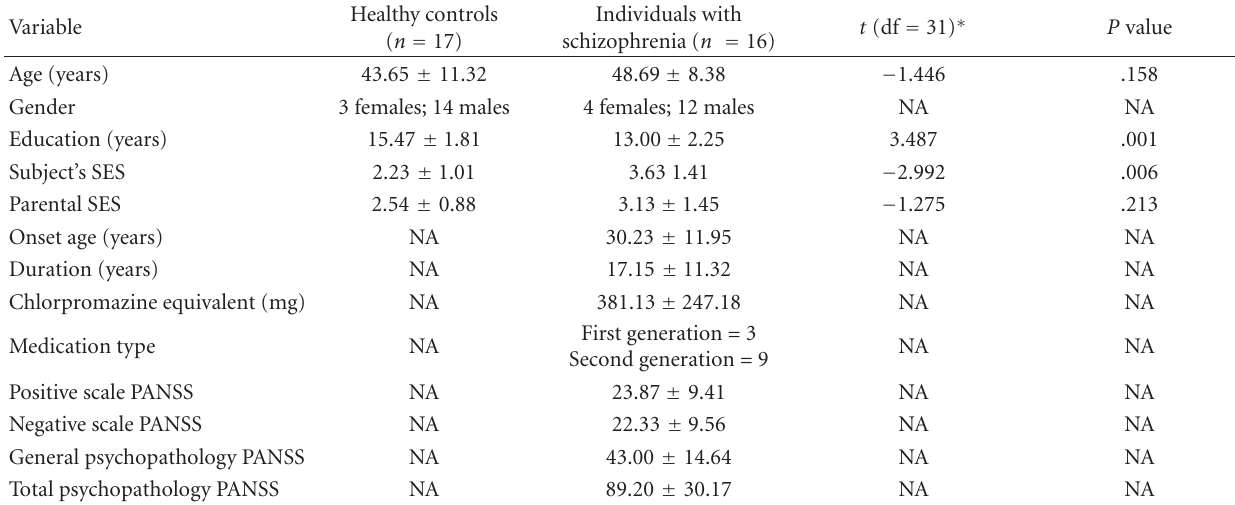
Table 1: Demographic and clinical characteristics of participants (mean ±